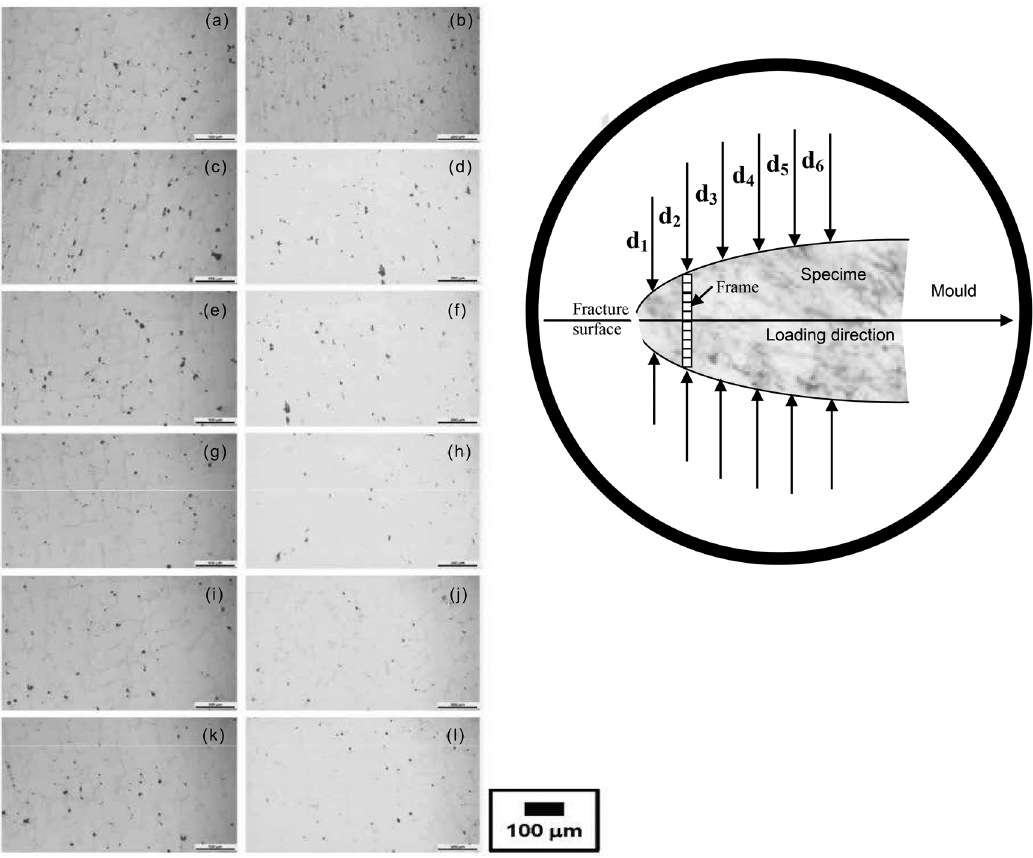
Figure 5: Extent of creep cavity at various stresses and strains (a, c, e, g, i, k) – 50 MPa and (b, d, f, h, j, l) – 68 MPa for the top tube. True strain at (a) 1.187, (c) 0.897, (e) 0.626, (g) 0.525, (i) 0.398 and (k) 0.359. (b) 0.781, (d) 0.652, (f) 0.565, (h) 0.40, (j) 0.244 and (l) 0.149 [8].